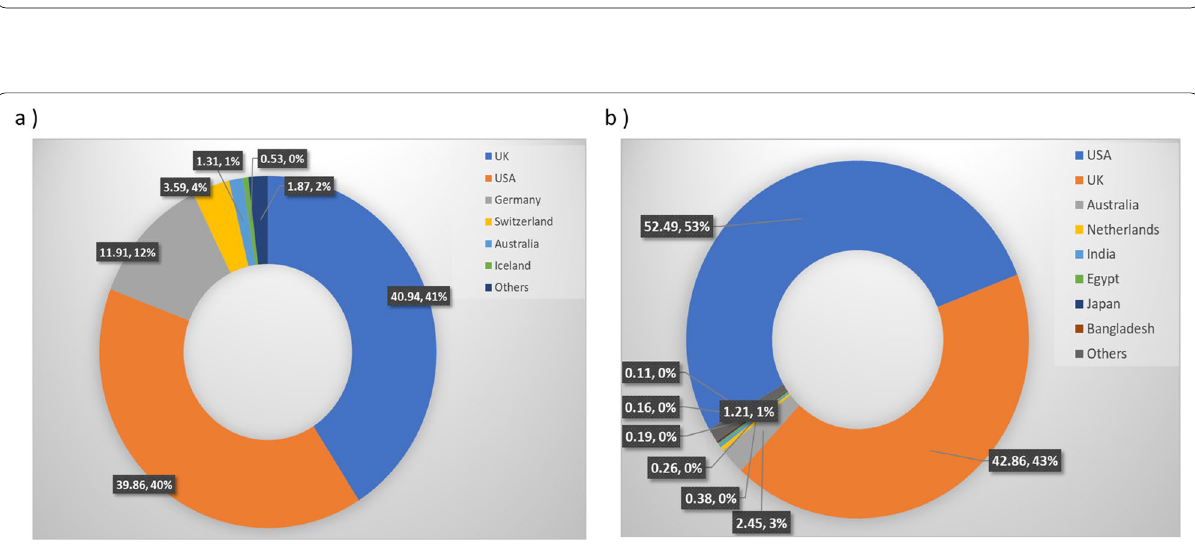
Fig. 2 Global distribution of severe acute respiratory syndrome coronavirus 2 (SARS-CoV-2) genomes by sample collection locations from 101 countries. a Distribution of 1,012,582 SARS-CoV-2 genomes (complete and partial genome sequence) by countries as of August 4th, 2021. b Global distribution of 405,461 complete SARS-CoV-2 genomes by region (from 88